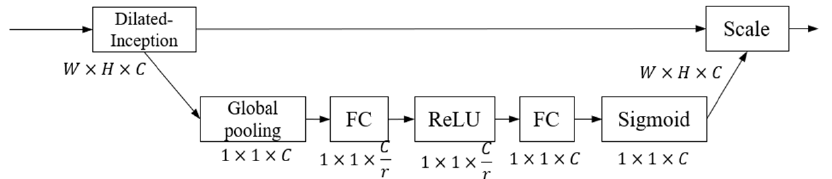
Figure 8. The DISE module consists of a dilated-inception block and an SE-Net block.